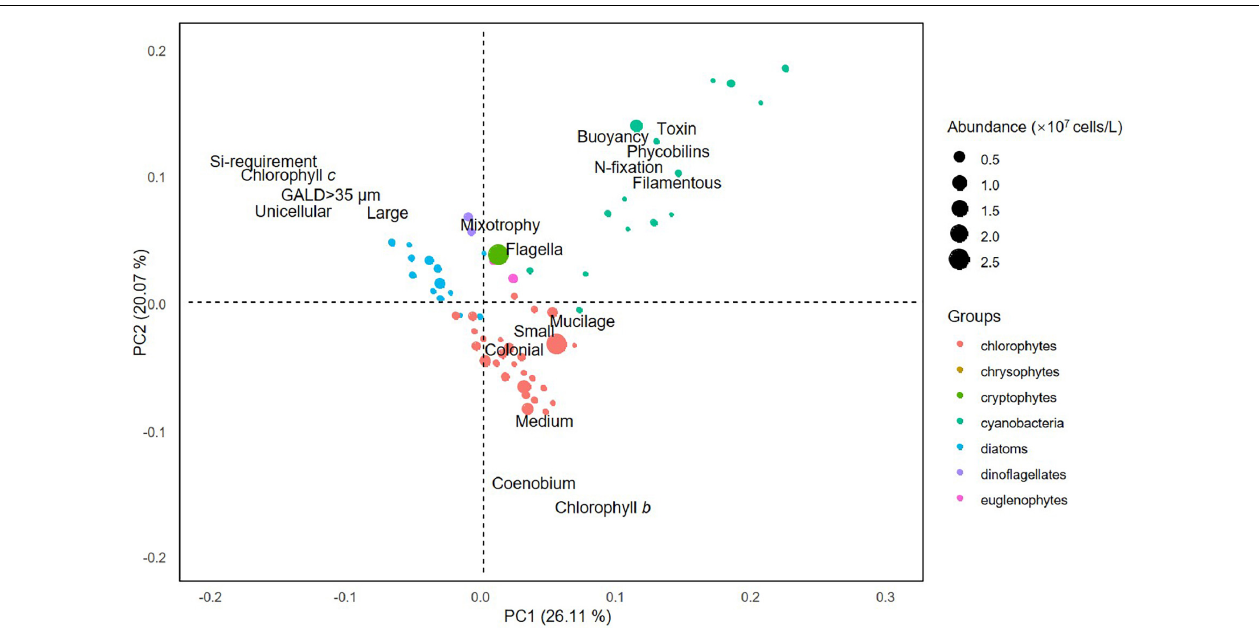
FIGURE 2 | Results of principal component analysis performed on the functional traits of phytoplankton